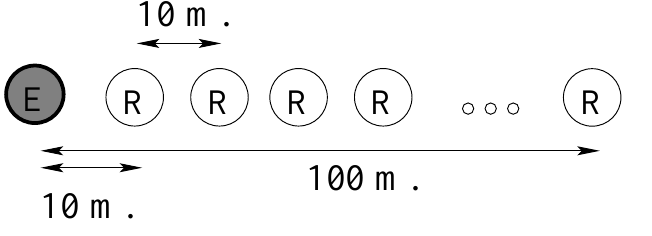
Figure 7. Physical arrangement of nodes for the Primary-Secondary radio link modelling experiment. Figure not to